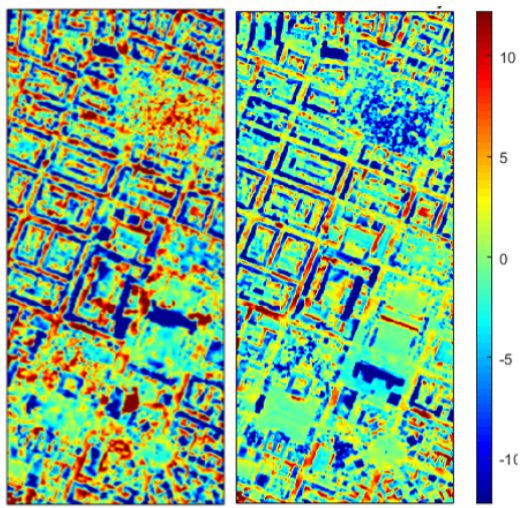
Figure 5. Height residual maps of inner city area: TanDEM-X DEM (Left) and Cartosat-1 DEM (Right)